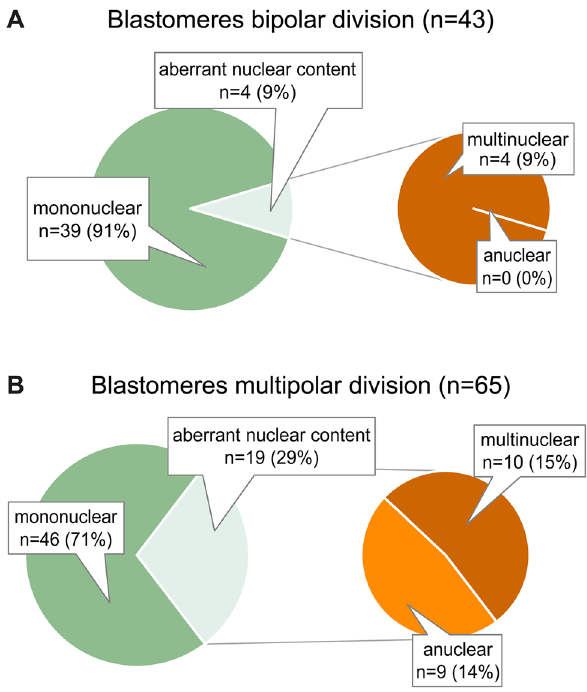
Figure 3. Number and percentages of blastomeres found to have a normal, mononuclear and aberrant (anuclear or multinuclear) content following bipolar ( B ) or multipolar zygotic divisions ( A